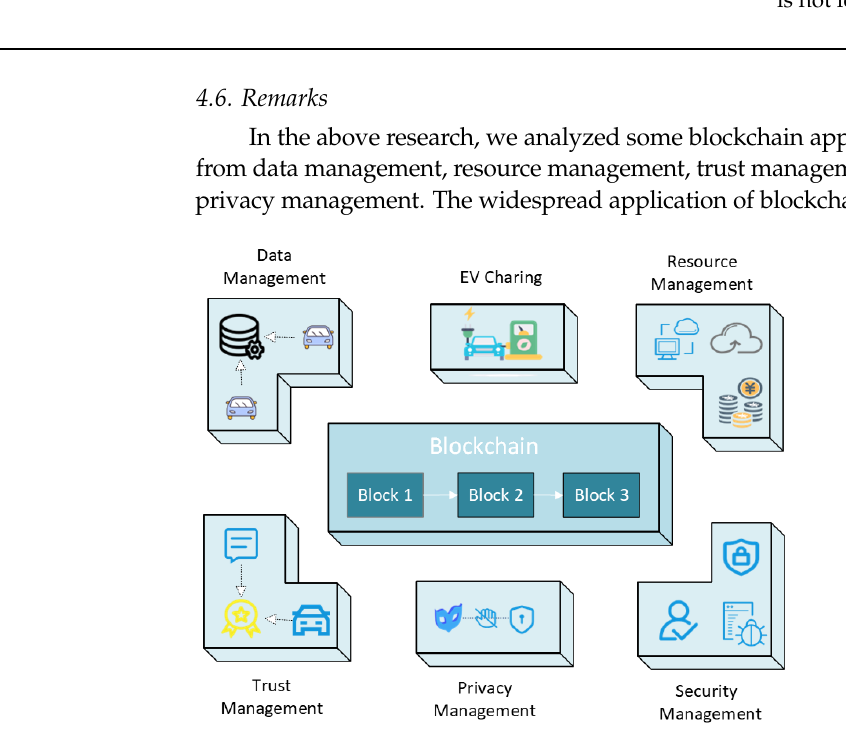
Figure 13. Applications of blockchain in